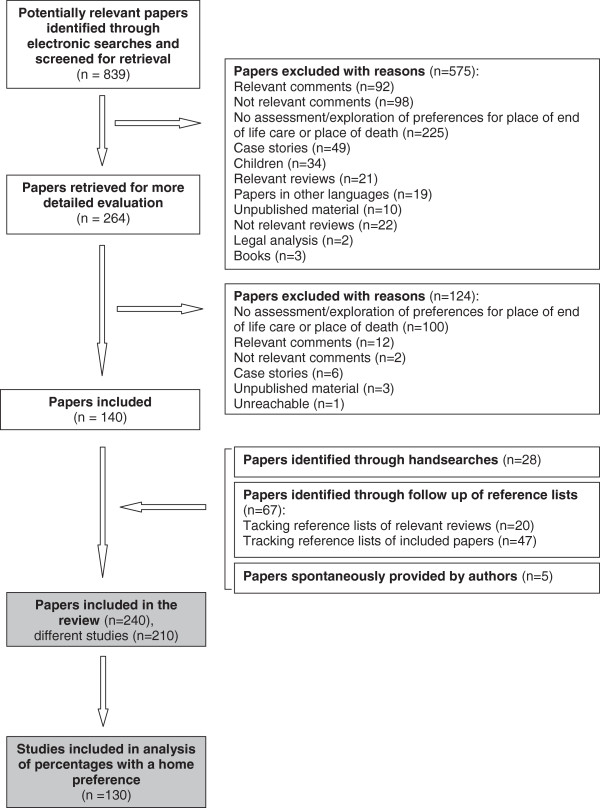
Flow of studies through review.